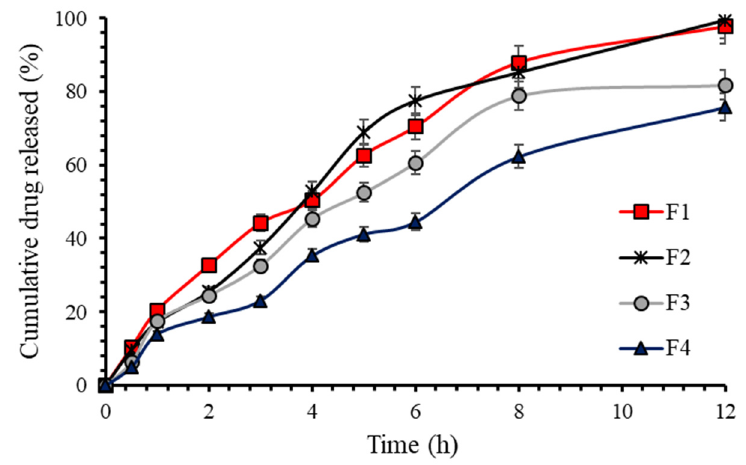
Figure 1. Percentage nizatidine release from floating tablets .